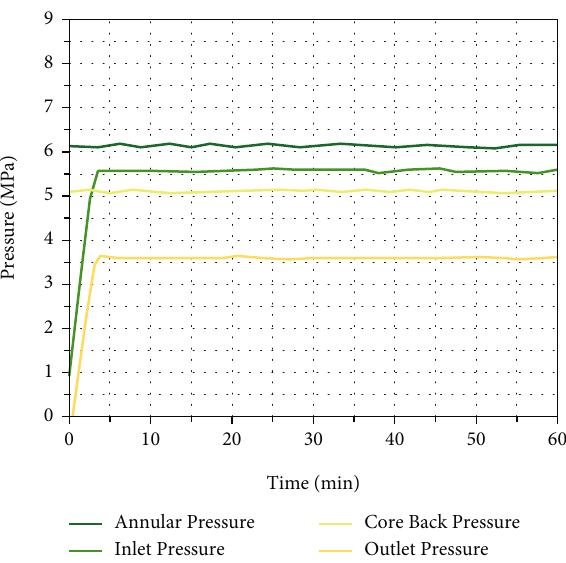
Figure 16: Experiment 7 plugging pressure